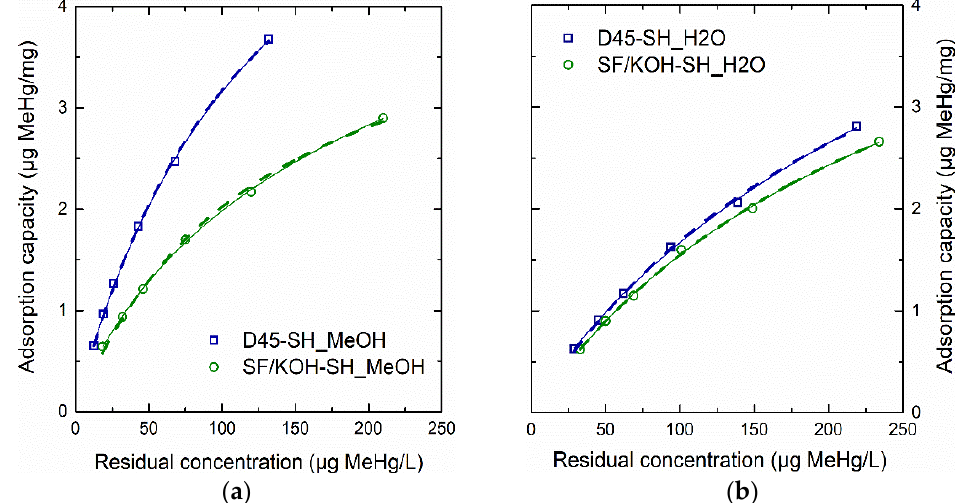
Figure 2. Adsorption isotherms of thio-functionalized materials in NSF water at pH 7. Solid lines represent the Freundlich model and dashed lines represent the Langmuir model: ( a ) MeOH matrix; ( b ) H 2 O matrix.